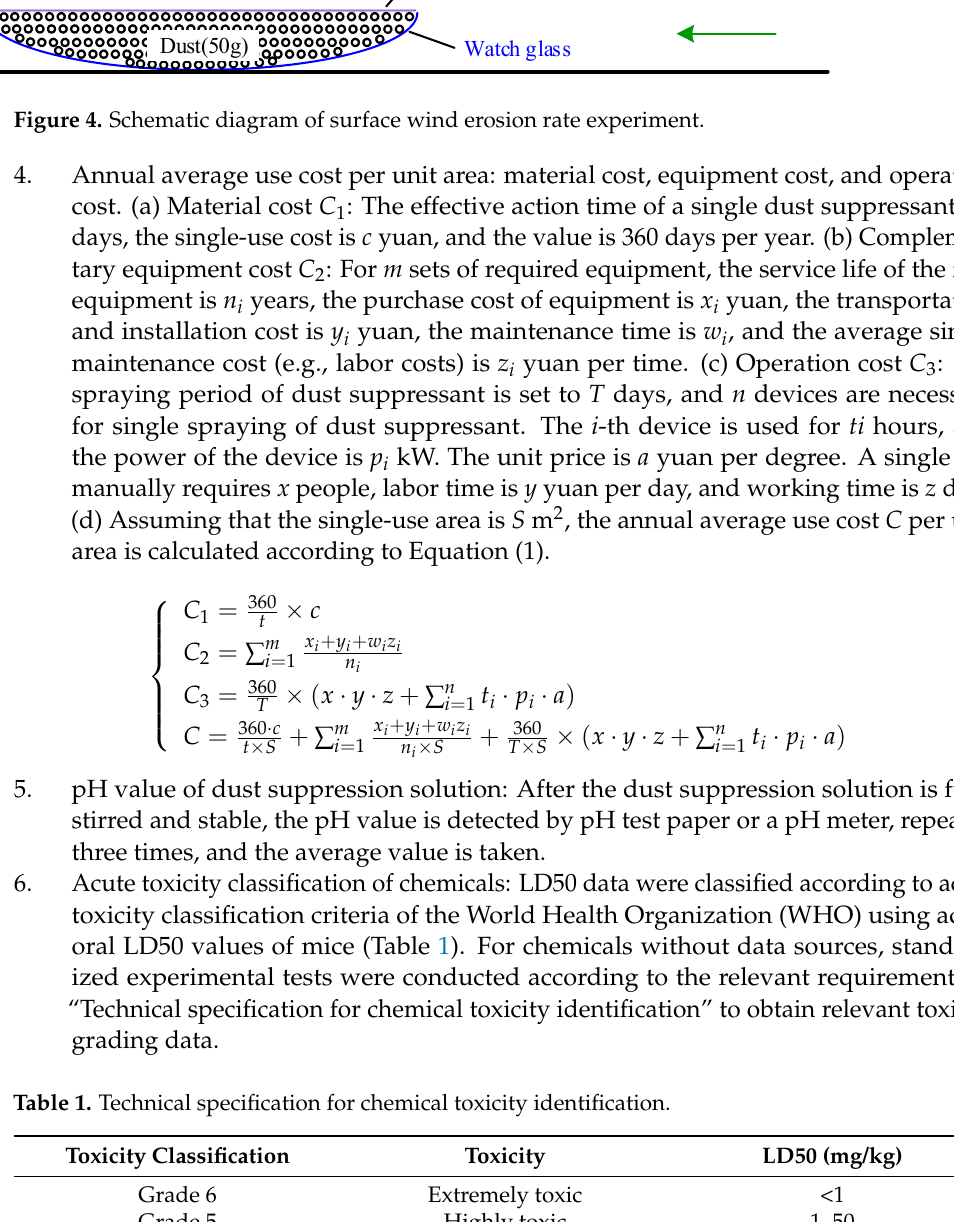
Table 1. Technical specification for chemical toxicity identification.